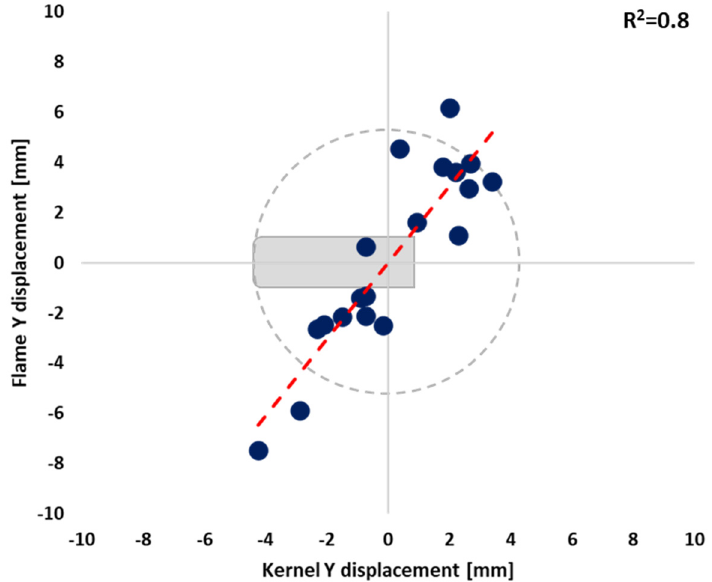
Figure 4. Comparison between the displacement along the direct tumble direction of the kernel and CA5 flames for the case of a single-electrode plug in cross-flow orientation ( λ = 1.15, SA = 12 CAD; the electrode is shown on the graph for scaling purpose only).